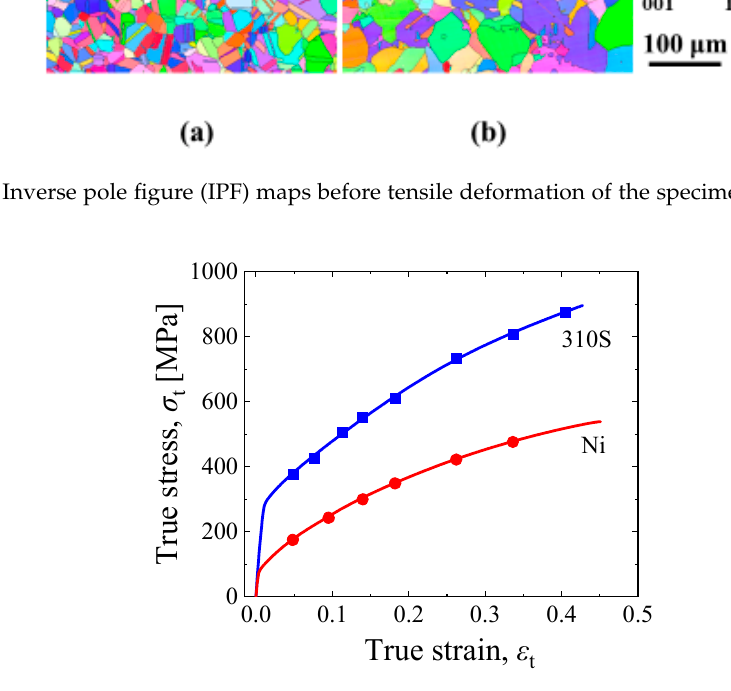
Figure 5. True stress-strain curves for 310S and Ni. Specimens were deformed at the strains denoted by each curve marks to conduct XRD measurements.